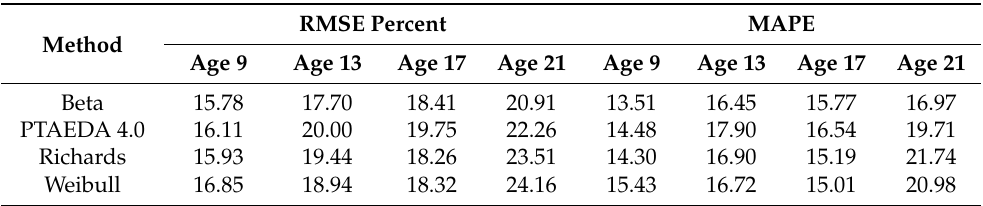
Table 5. Root mean square error percent and mean absolute percent error produced by four LCR models at different